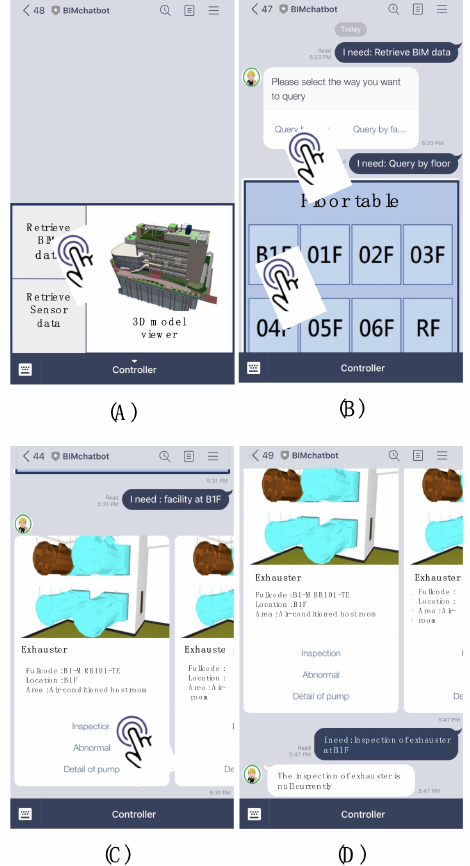
Figure 13. Example of the operation of the chatbot prototype using designed interface: ( A ) click Retrieve BIM data from the rich menu, ( B ) click Query by floor and select B1F from the imagemap, ( C ) find the designated facility and click Inspection, ( D ) the chatbot replies to the user with the inspection